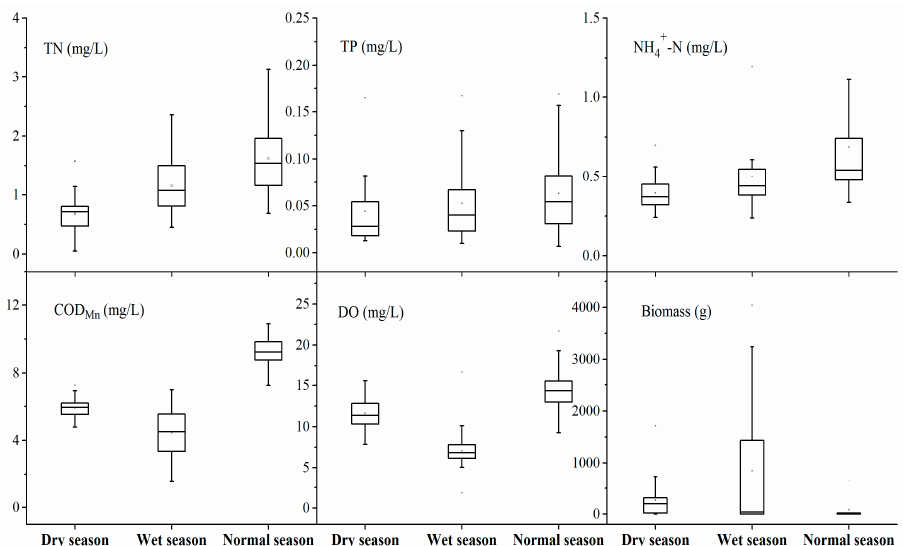
Figure 3. The annual mean values of water quality parameters and biomass in dry, wet and normal seasons.